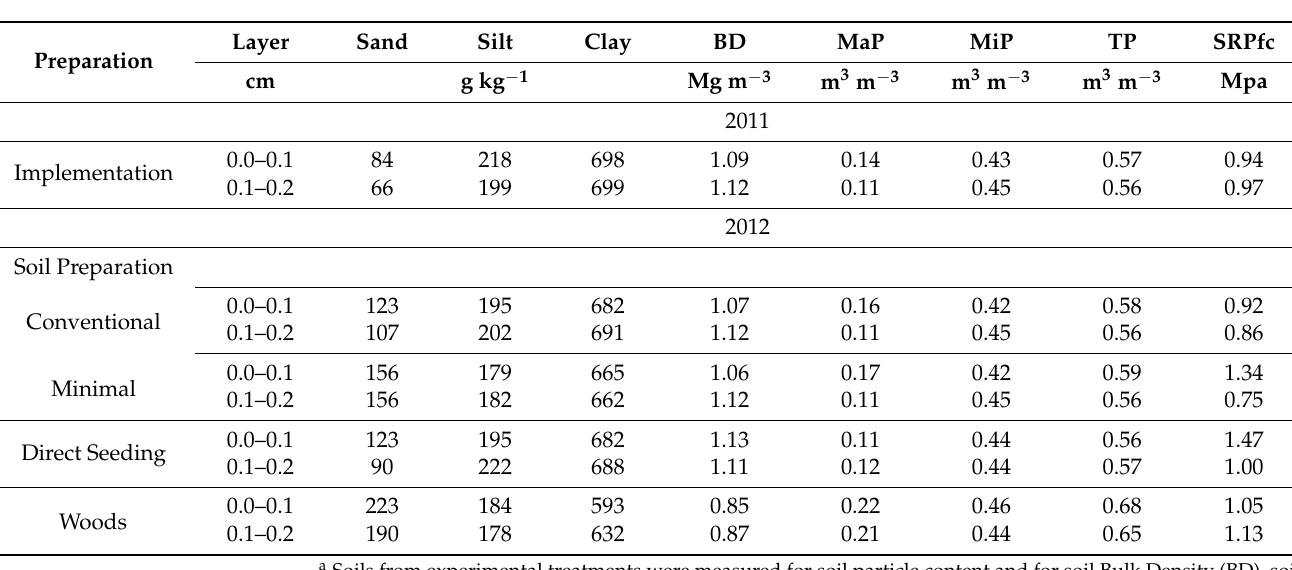
Table 2. Physical attributes a of soils with different preparations under the cultivation of irrigated wheat in 2011 and 2012 in Tangar á da Serra, Mato Grosso state,